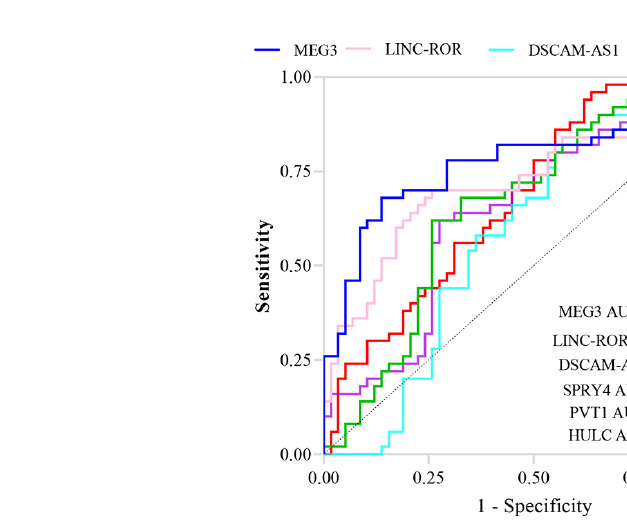
FIGURE 3 | ROC curves showing the power of lncRNAs in separation of PD patients from